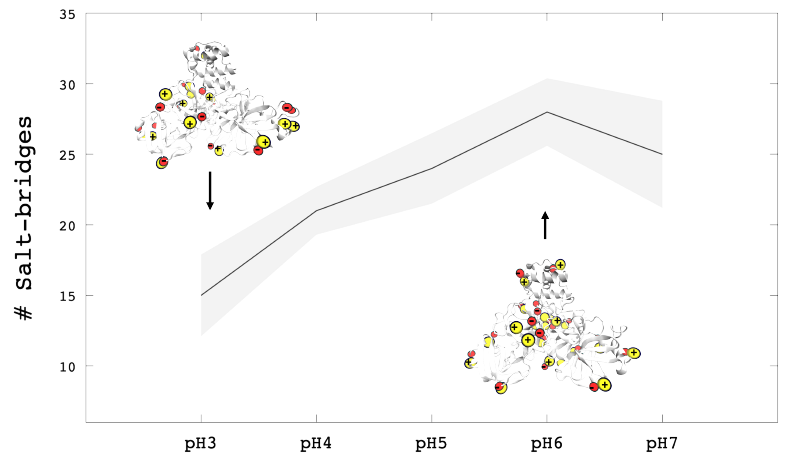
Figure 5. Salt bridges of whole Mpro structure at different conditions of pHs. At low pHs, Mpro is more protonated than pH 6 and pH 7, this graphic show less salt bridges at pH 3. The line-tendency (black) represent the average value and the smooth tendency (gray) represent the statistical error.